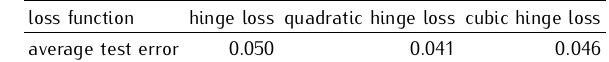
Table 2. The average misclassification rate obtained via the two nested